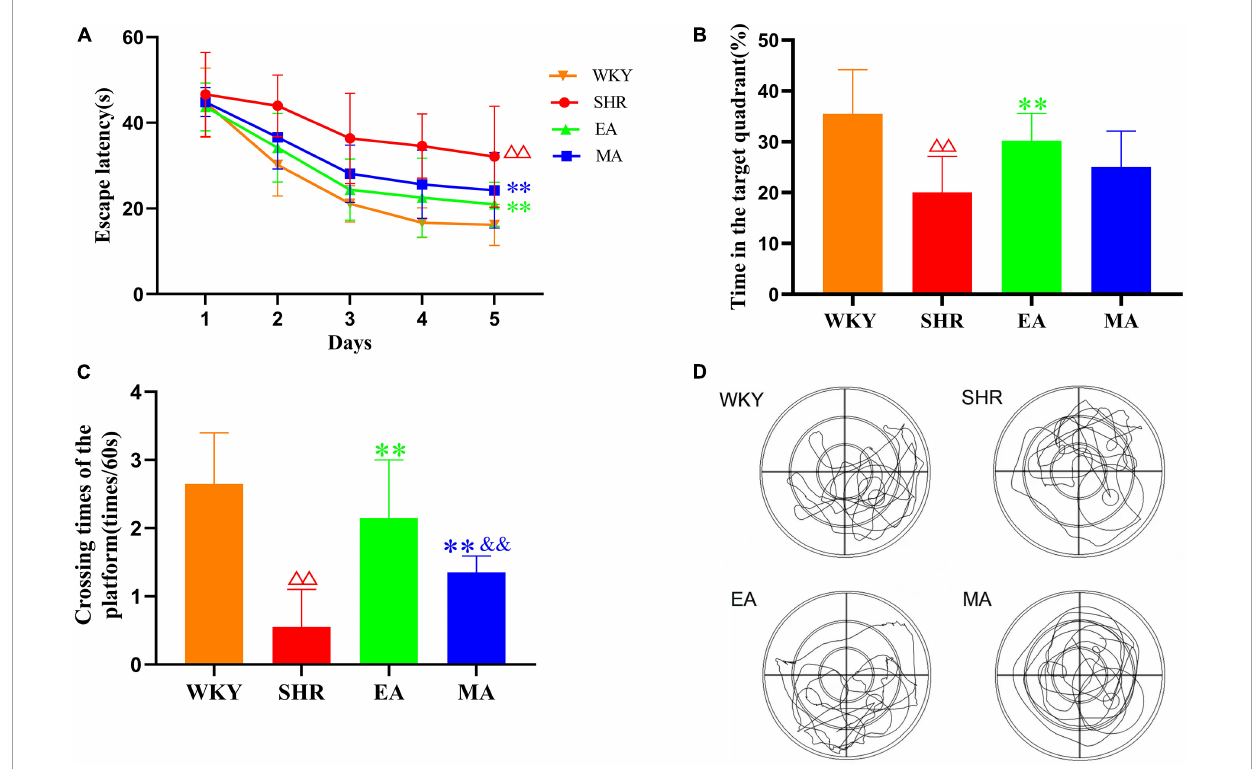
FIGURE2 Electroacupuncture and manual acupuncture protect the cognitive functions of spontaneously hypertensive rats (SHRs). The Morris water maze test was performed in the Wistar–Kyoto (WKY), SHR, EA, and MA groups. (A) Escape latency. (B) Time spent in the target quadrant. (C) The number of platform crossings. The values are presented as the mean ± SEM ( n = 10 rats/group). (D) Typical swimming traces in the probe trial. (cid:49)(cid:49) p < 0.01 vs. WKY group; ∗∗ p < 0.01 vs. SHR group; && p < 0.01 vs. EA group. WKY, normal control group; SHR, model group; EA, electroacupuncture group; MA, manual acupuncture